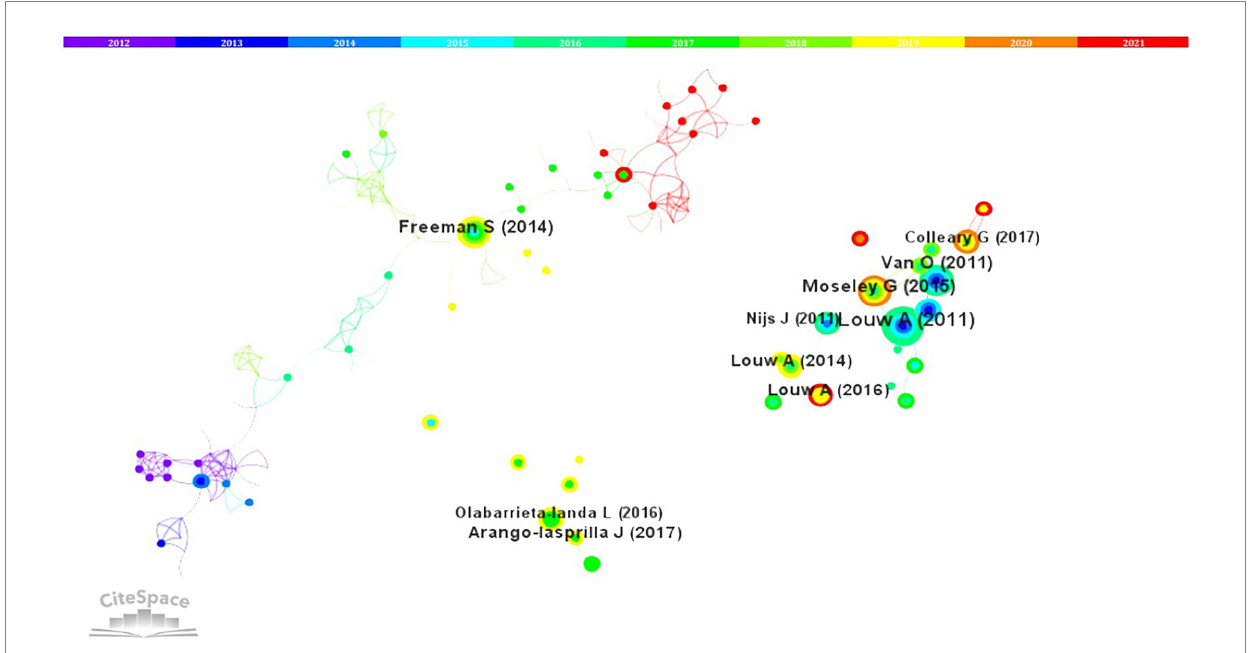
FIGURE 9 The network of co-cited references in physiology teaching reform